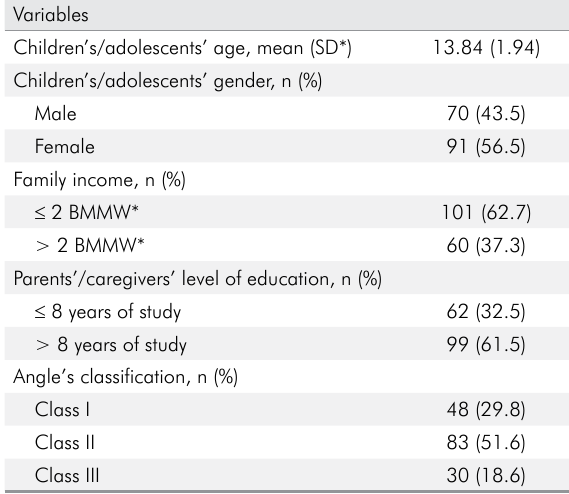
Table 1. Sociodemographic and orthodontic characteristics of the